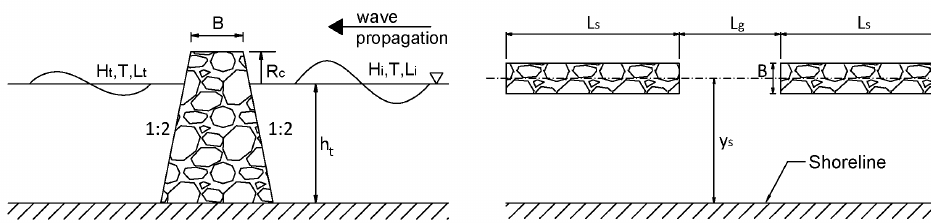
Figure 2. Sketch of the most relevant design characteristics of emerged ( R c > 0 ) or submerged ( R c < 0 ) rubble-mound breakwater in a vertical cross-section ( left panel) and in a plan view ( right panel).